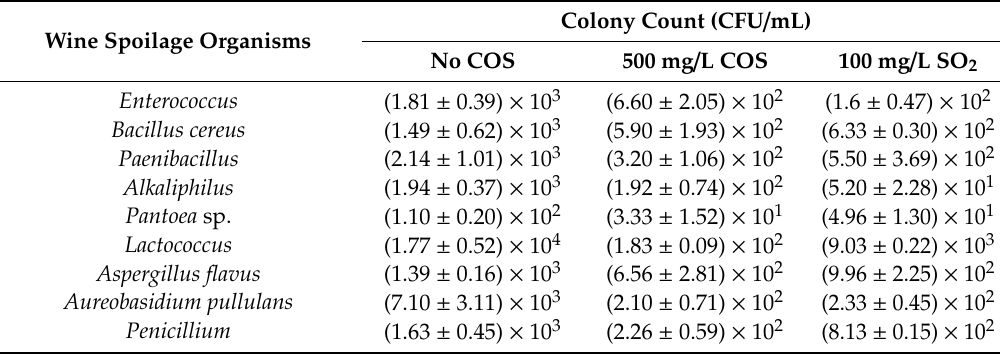
Table 3. Comparative analysis of antimicrobial e ff ects on nine di ff erent wine spoilage organisms between using 500 mg / L COS and 100 mg / L SO 2 as